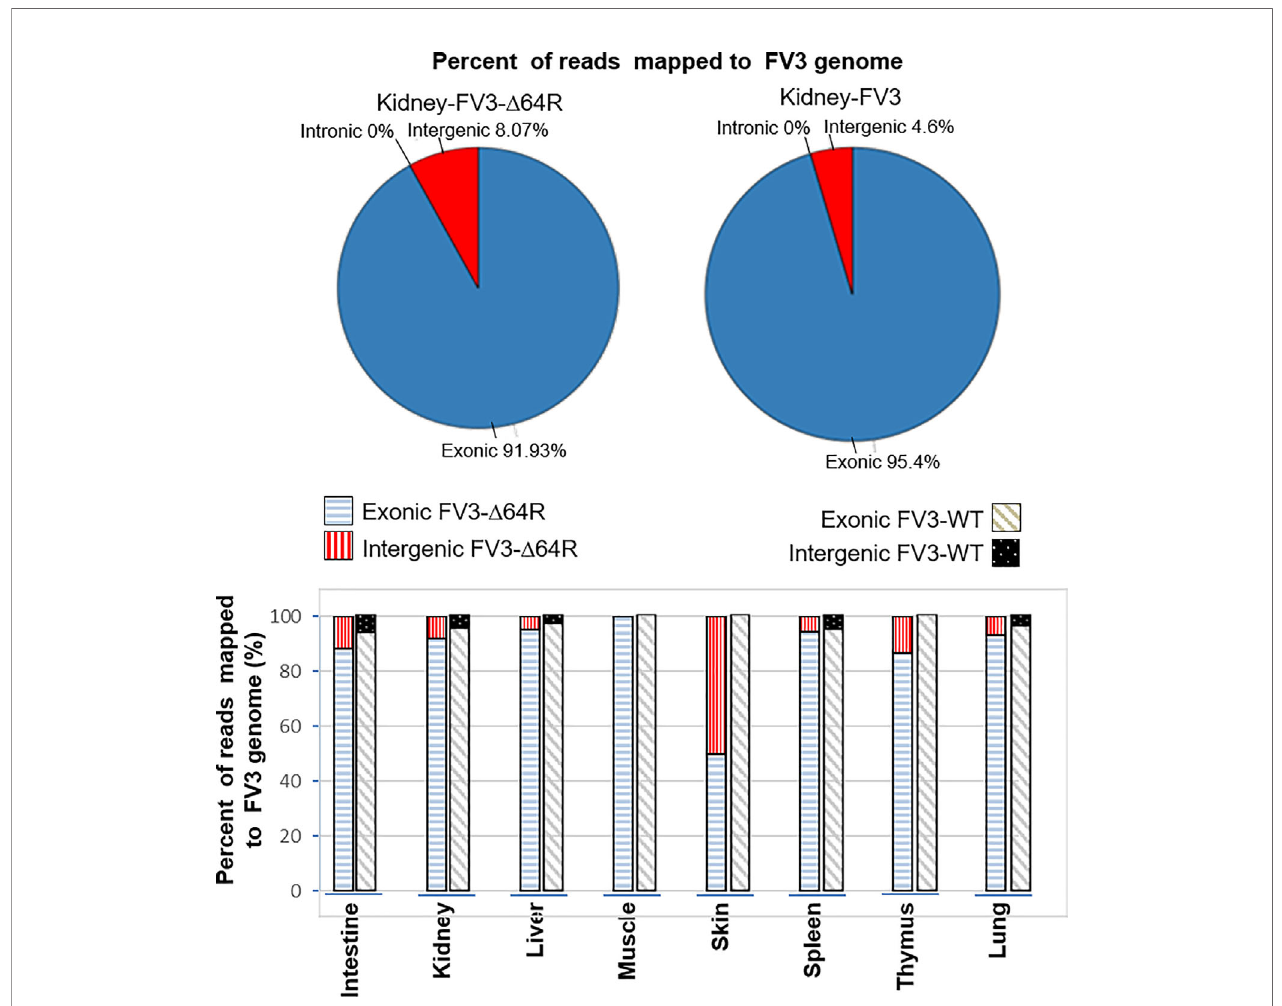
FIGURE 1 | Percent of reads mapped to functionally different regions on FV3 genome. The FV3 genome regions are functionally classi fi ed as exons, introns, or intergenic regions based on annotation of the reference genome (NC_005946.1). As intronic regions (introns) are lacking in ranaviral coding genes, about 50 intergenic regions are interspersed between ORFs. The intergenic regions take about 20% of the FV3 genome with a length of 20-900 bp. Transcriptomic reads in most infected tissues are also remarkably mapped within these intergenic regions, indicating that these intergenic regions are transcribed and probably function as regulatory RNA